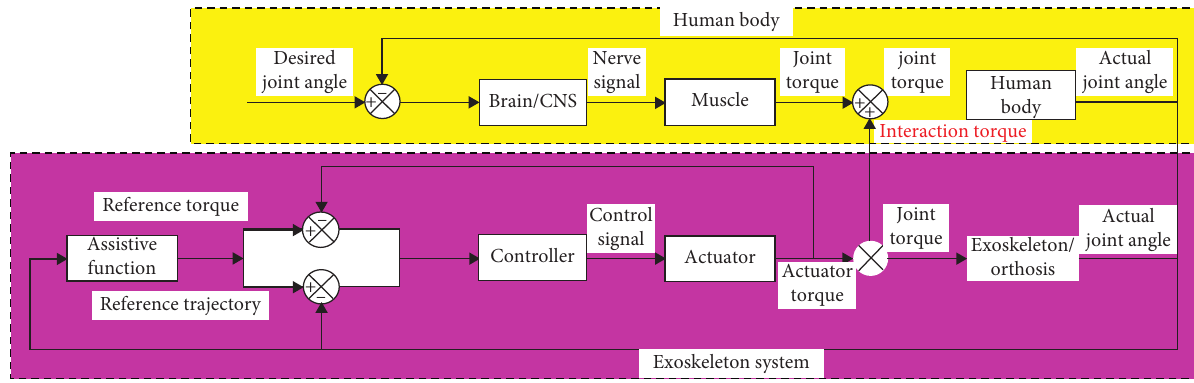
Figure 2: Human-exoskeleton cooperation system [4].